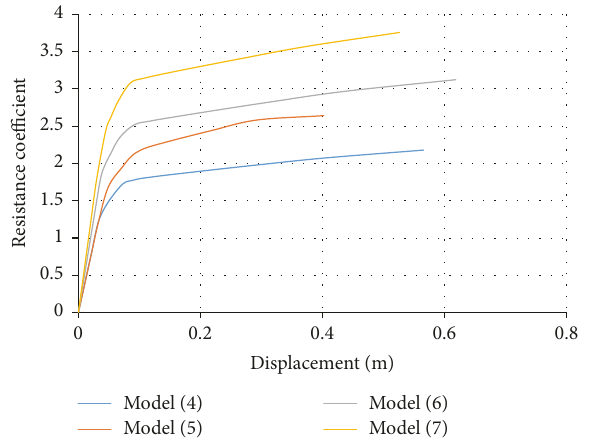
Figure 21: Vertical displacement-resistance coefficient relationship ofmodelswithdifferentbeamparametersafterremovingthebottom middle column.